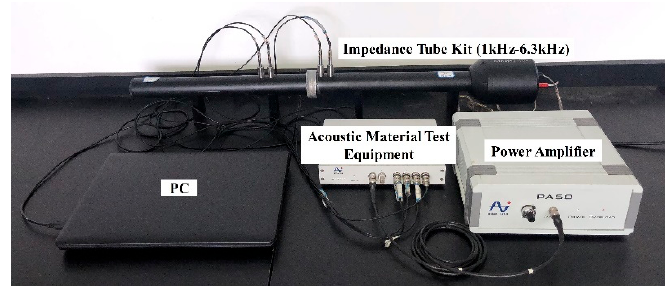
Figure 3. Acoustic property test system.